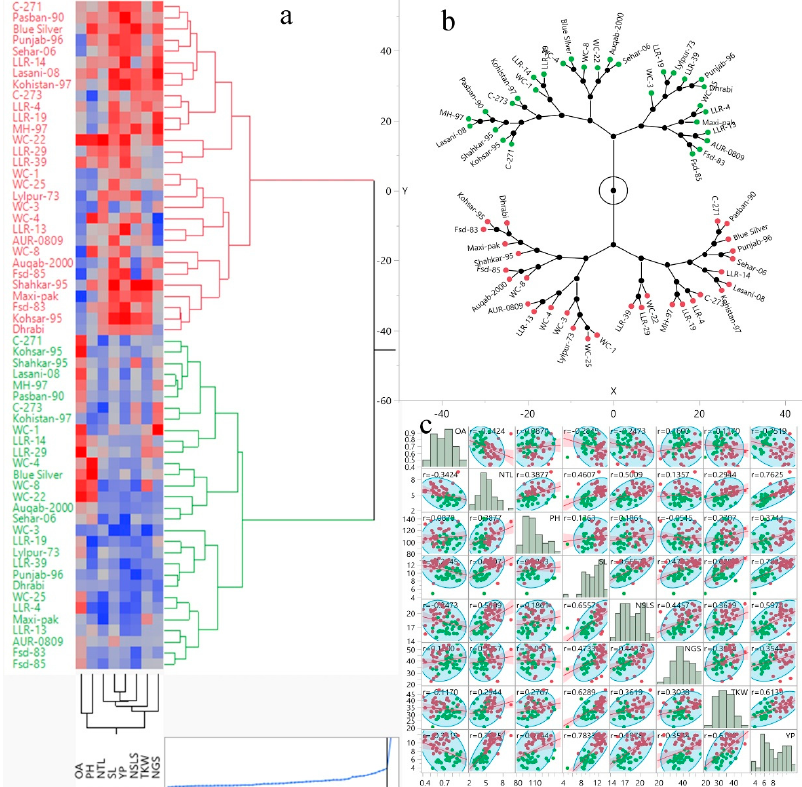
Figure 4. Hierarchical Cluster ( a ), Constellation Plot ( b ) and overall correlation matrix ( c ) of 30 wheat genotypes assessed under WW and DS conditions. Genotypes are distributed in three major and two minor groups in the WW condition. In contrast, genotypes evaluated under DS condition are distributed in four major and 5 minor groups. Here, red color denoted to WW and green to DS. The major and minor groups are classified as having genotypes > 6 and > 3 respectively.